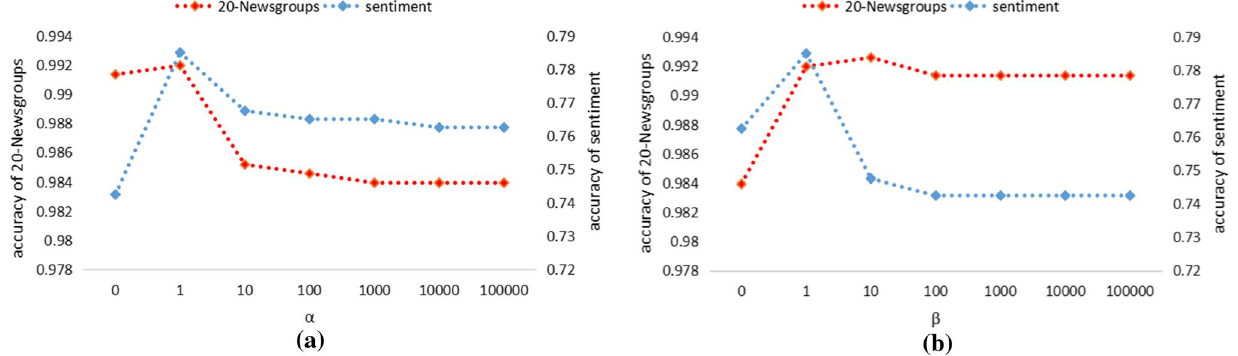
Fig. 3 Effectiveness experiment of